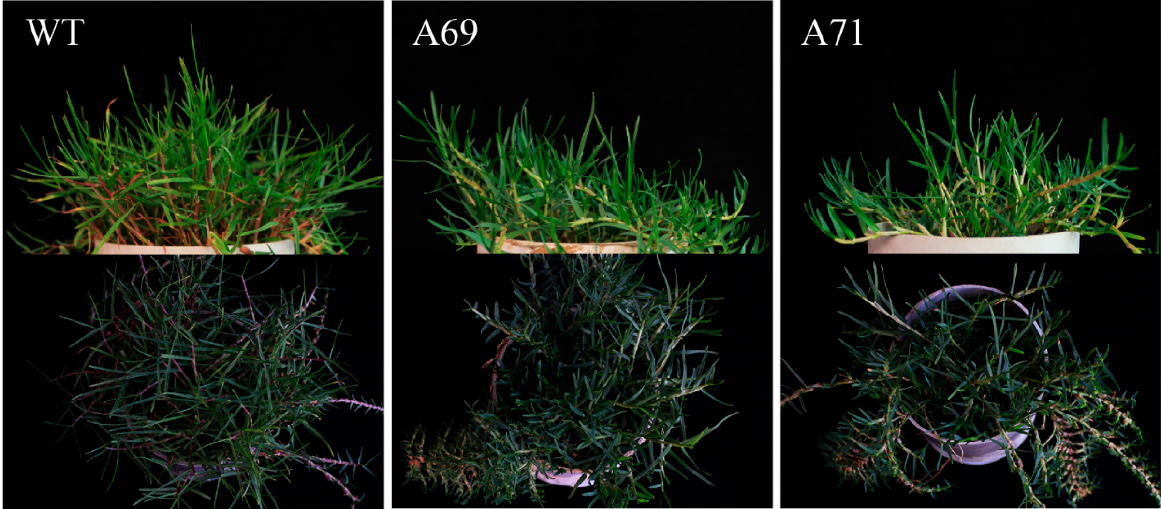
Figure 3. WT and mutants with a green leaf sheath color (A69 and A71).